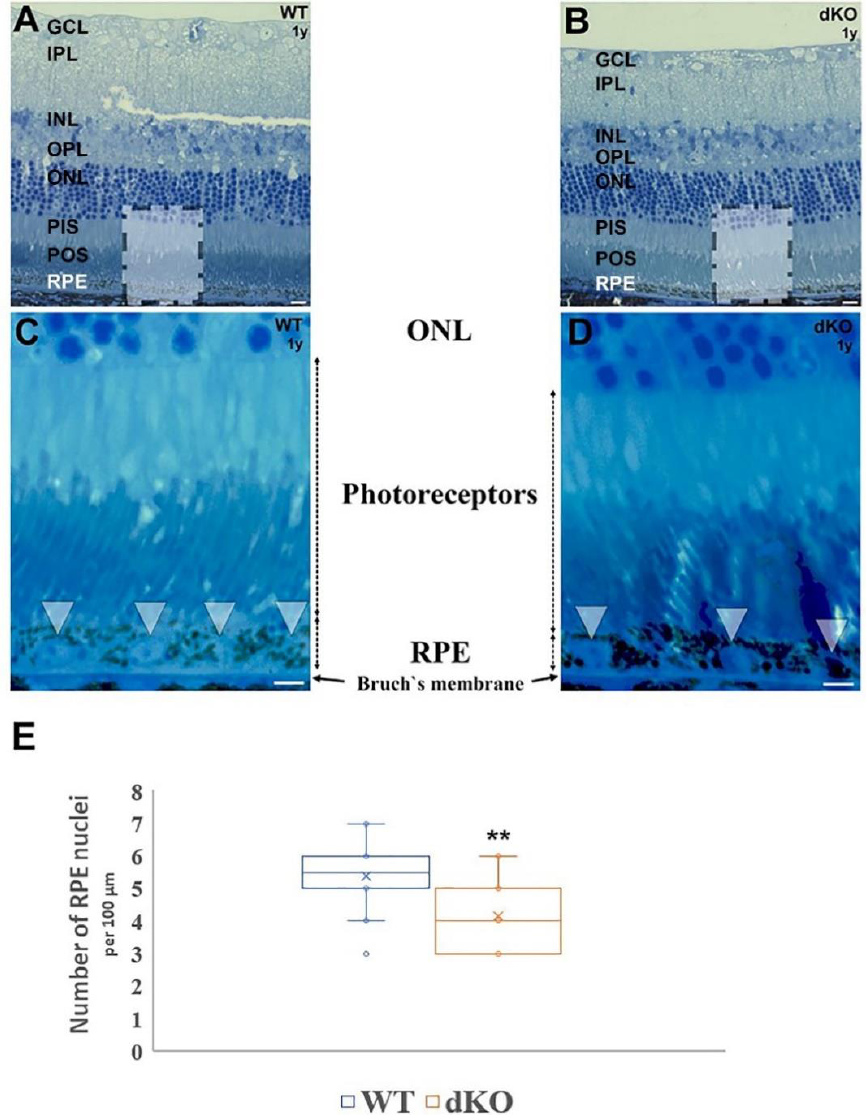
Figure 1. Light micrographs of toluidine stained semithin retinal sections derived from one-year-old wild-type (WT) and NFE2L2/PGC-1 α dKO mice. Retinal cross sections were prepared from one-year-old WT control mice ( A , C ) and dKO samples ( B , D ) and plastic sections were stained with toluidine blue. Boxed areas are shown with high power in ( C , D ). The RPE cell layer from WT animals is thicker, with a higher number of nuclei (arrowheads in ( C )) compared to age-matched dKO littermates (arrowheads in ( D )). In the NFE2L2/PGC-1 α dKO mice RPE layer is flattened. Melanin granules tend to occupy more of their cytoplasm. ( E ) illustrates the decrease in the density of RPE nuclei for double knockout animals, relative to the age-matched WT littermates ( n = 30). ** p < 0.001 (Mann-Whitney U-test). Abbreviations: GCL: ganglion cell layer; IPL: inner plexiform layer; INL: inner